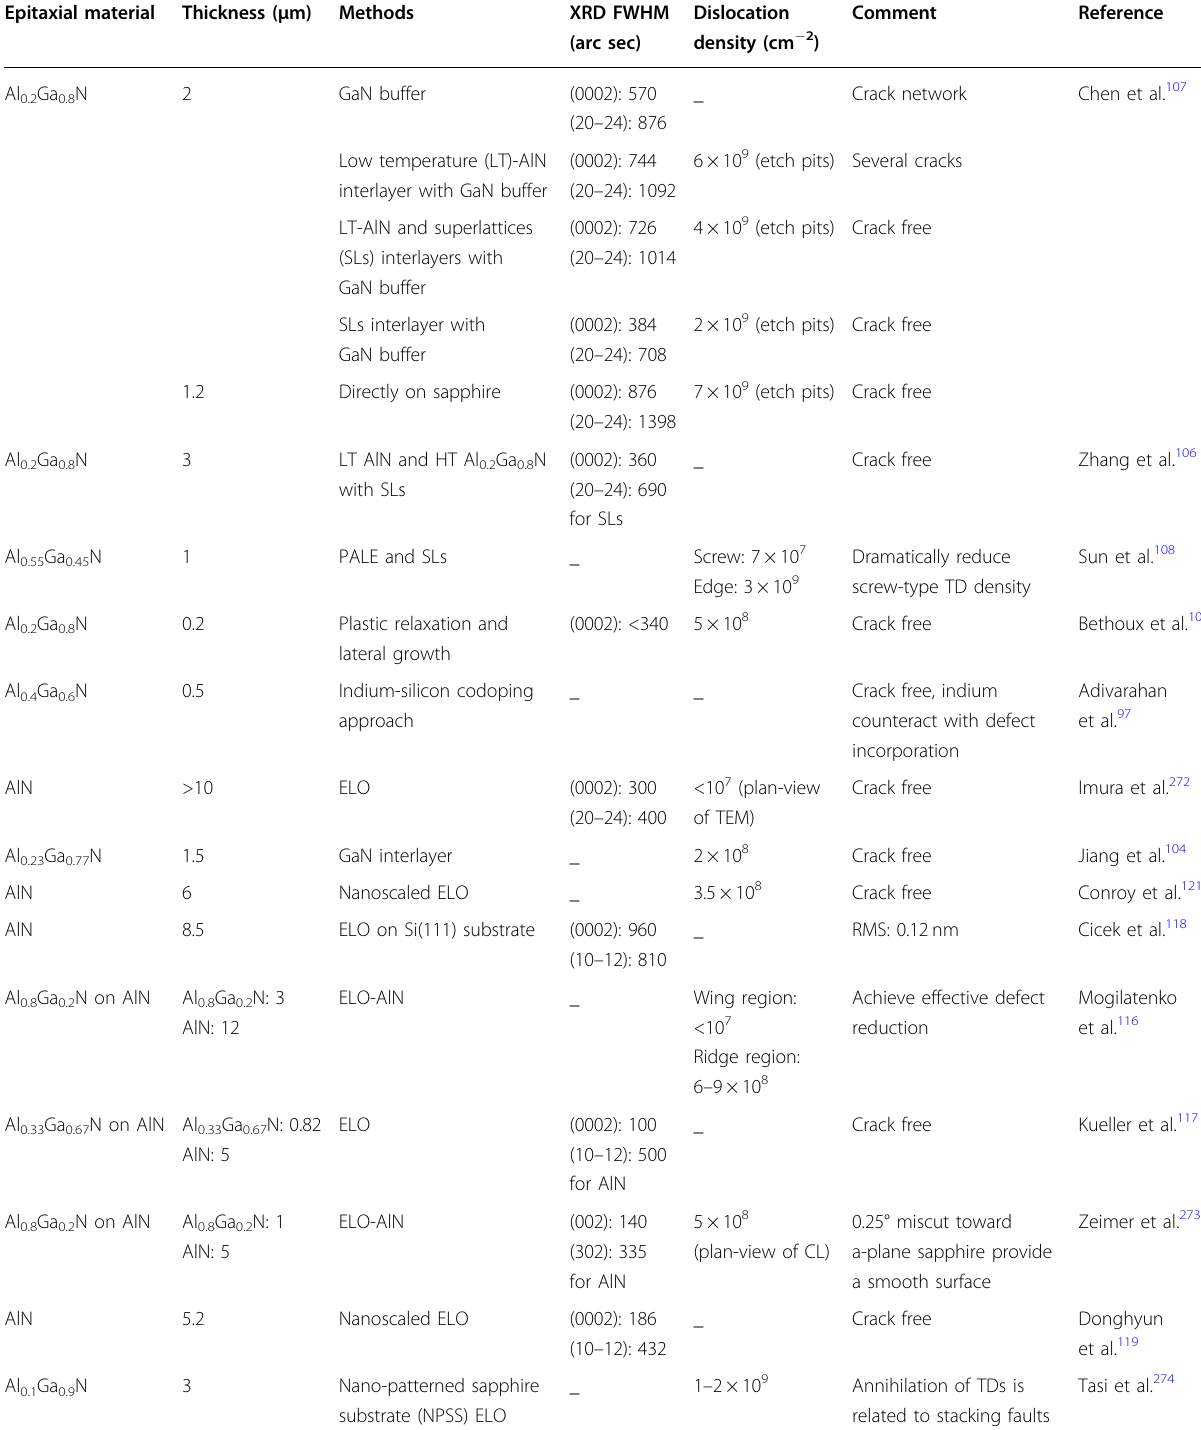
Table 1 Summary of AlGaN and AlN epitaxial progress Epitaxial